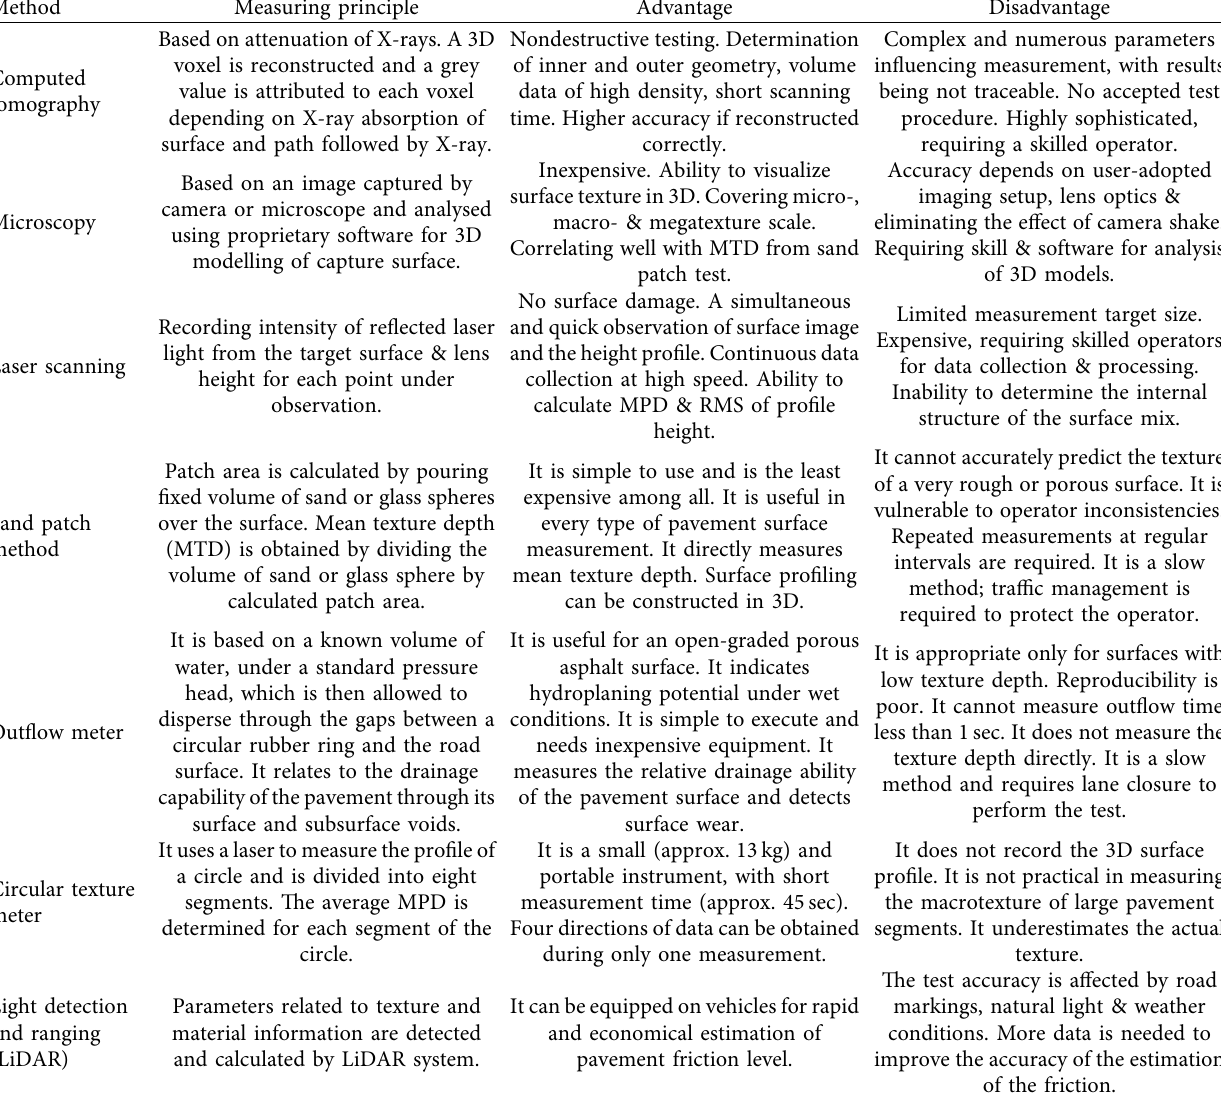
Table 3: Overview of pavement surface texture measurement methods.